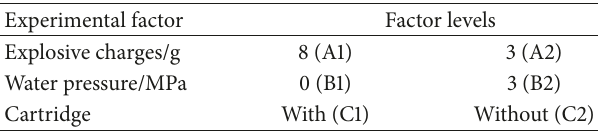
Table 1: Experimental factors and